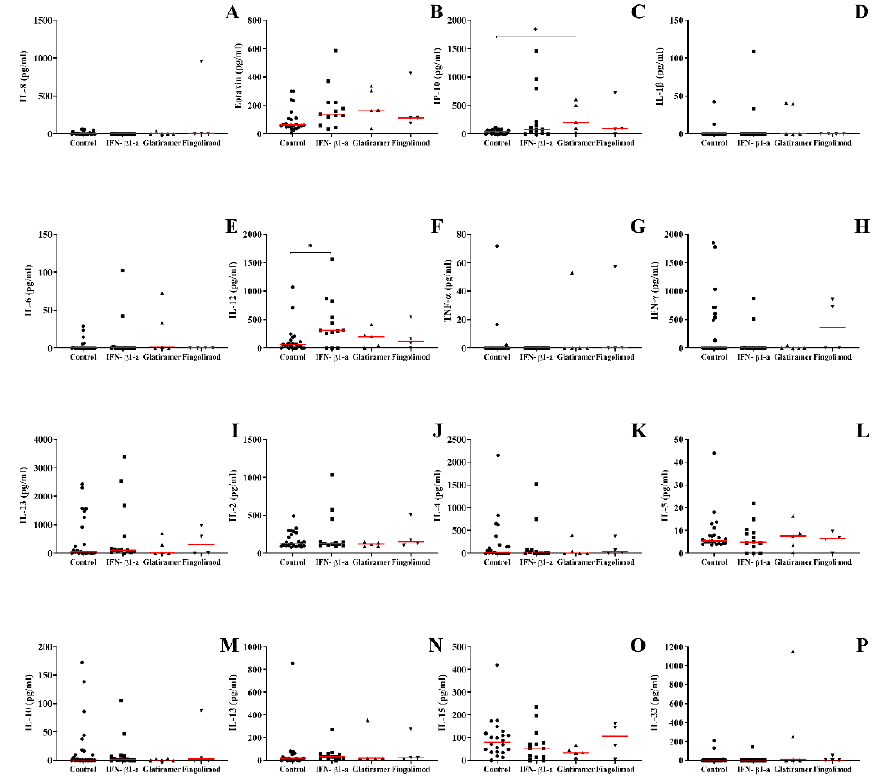
Figure 5. Concentration of cytokines and chemokines in patients with multiple sclerosis separated into groups according to the treatment used obtained by enzyme-linked immunosorbent assay: ( A ) IL-8, ( B ) CCL-11/eotaxin-1, ( C ) CXCL-10/IP-10, ( D ) IL-1 β , ( E ) IL-6, ( F ) IL-12, ( G ) TNF- α , ( H ) IFN- γ , ( I ) IL-23, ( J ) IL-2, ( K ) IL-4, ( L ) IL-5, ( M ) IL-10, ( N ) IL-13, ( O ) IL-15, and ( P ) IL-33. Healthy control; IFN- β 1-a = relapse–remitting multiple sclerosis patients treated with interferon β 1-a; glatiramer acetate = relapse – remitting multiple sclerosis patients treated with glatiramer acetate; fingolimod = relapse – remitting multiple sclerosis patients treated with fingolimod. Rows represent the median. Statistical analysis was performed using the Kruskal – Wallis test with Dunn ’s post-test, where * represents p < 0.05.